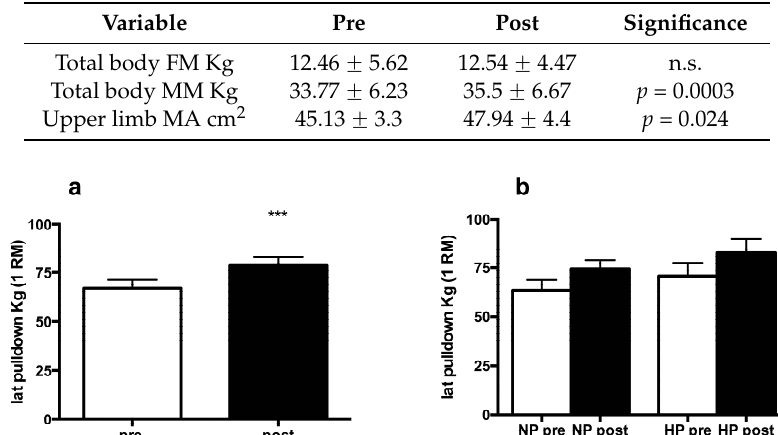
Table 2. Anthropometric variables before and after eight weeks of resistance training (all subjects). Mean ˘ Standard Error are reported. (FM = fat mass; MM = muscle mass; MA = muscle area); upper limb was the dominant one.